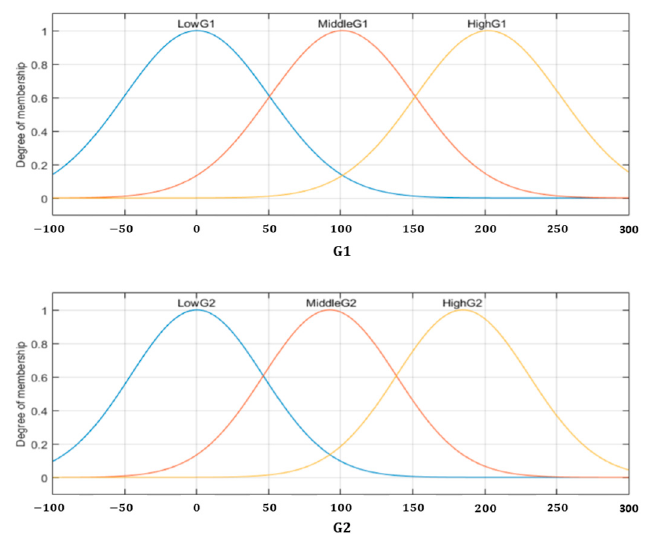
Figure 8. Inputs MFs for the Fuzzy MG.